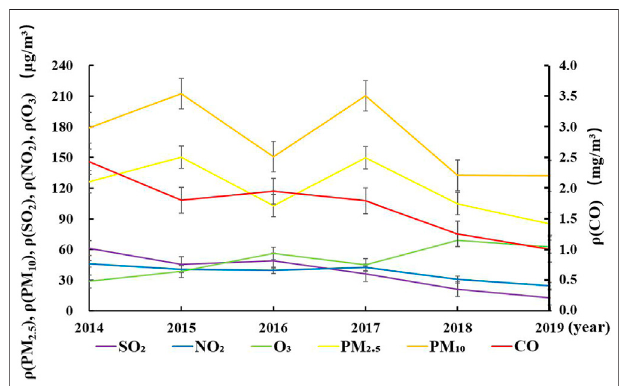
FIGURE 3 | Annual change trend of average concentration of main pollutants in Zhengzhou during the Spring Festival from 2014 to 2019.